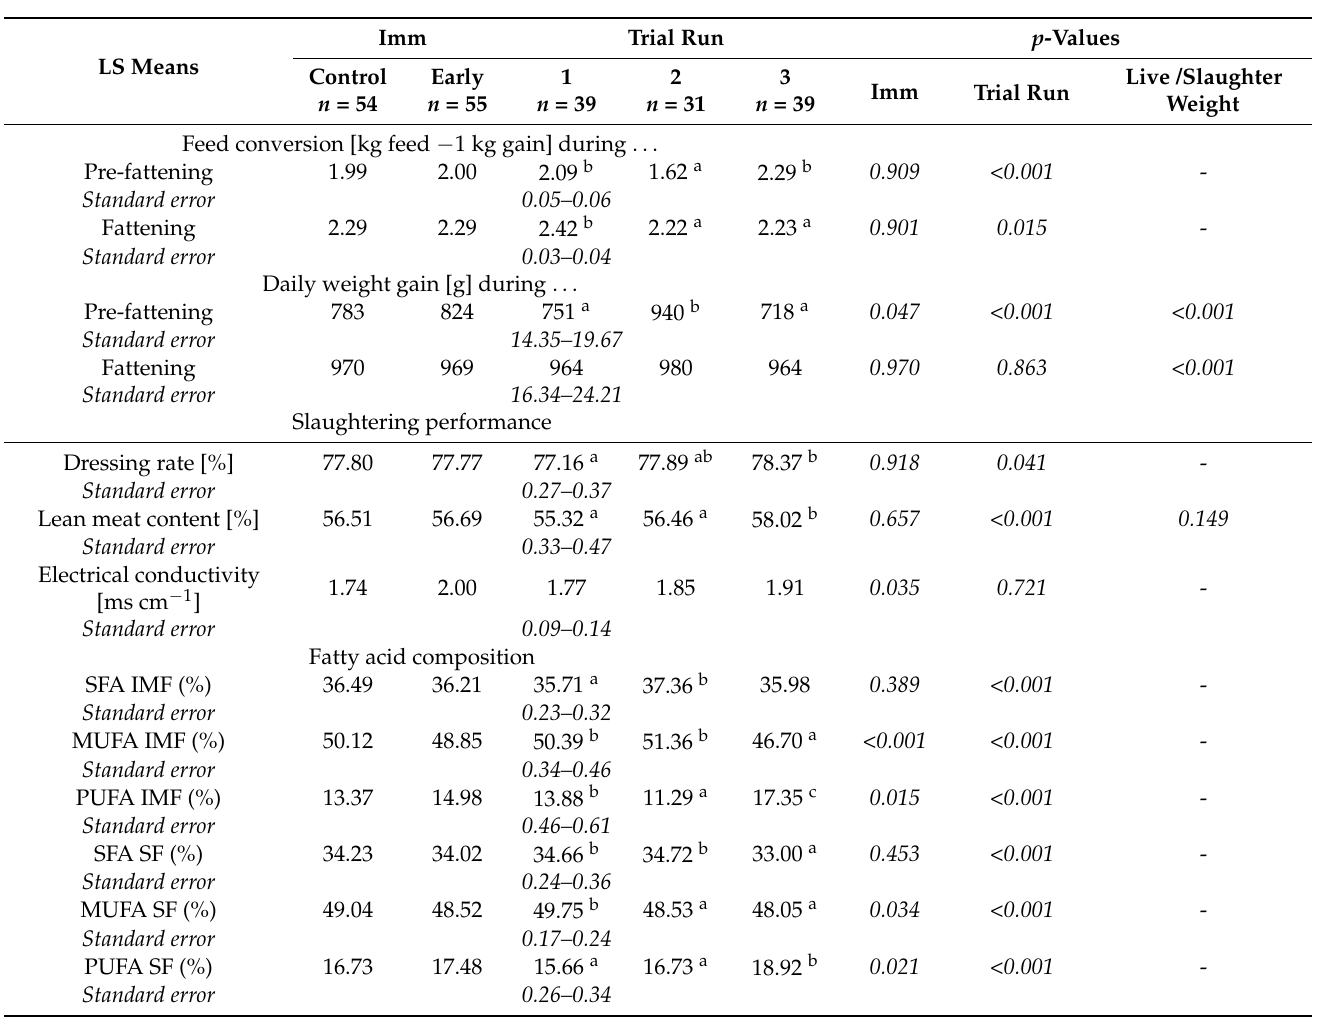
Table A2. Fattening and slaughtering performance and fatty acid composition of intramuscular fat (IMF) and subcutaneous fat (SF) according to immunization scheme and trial